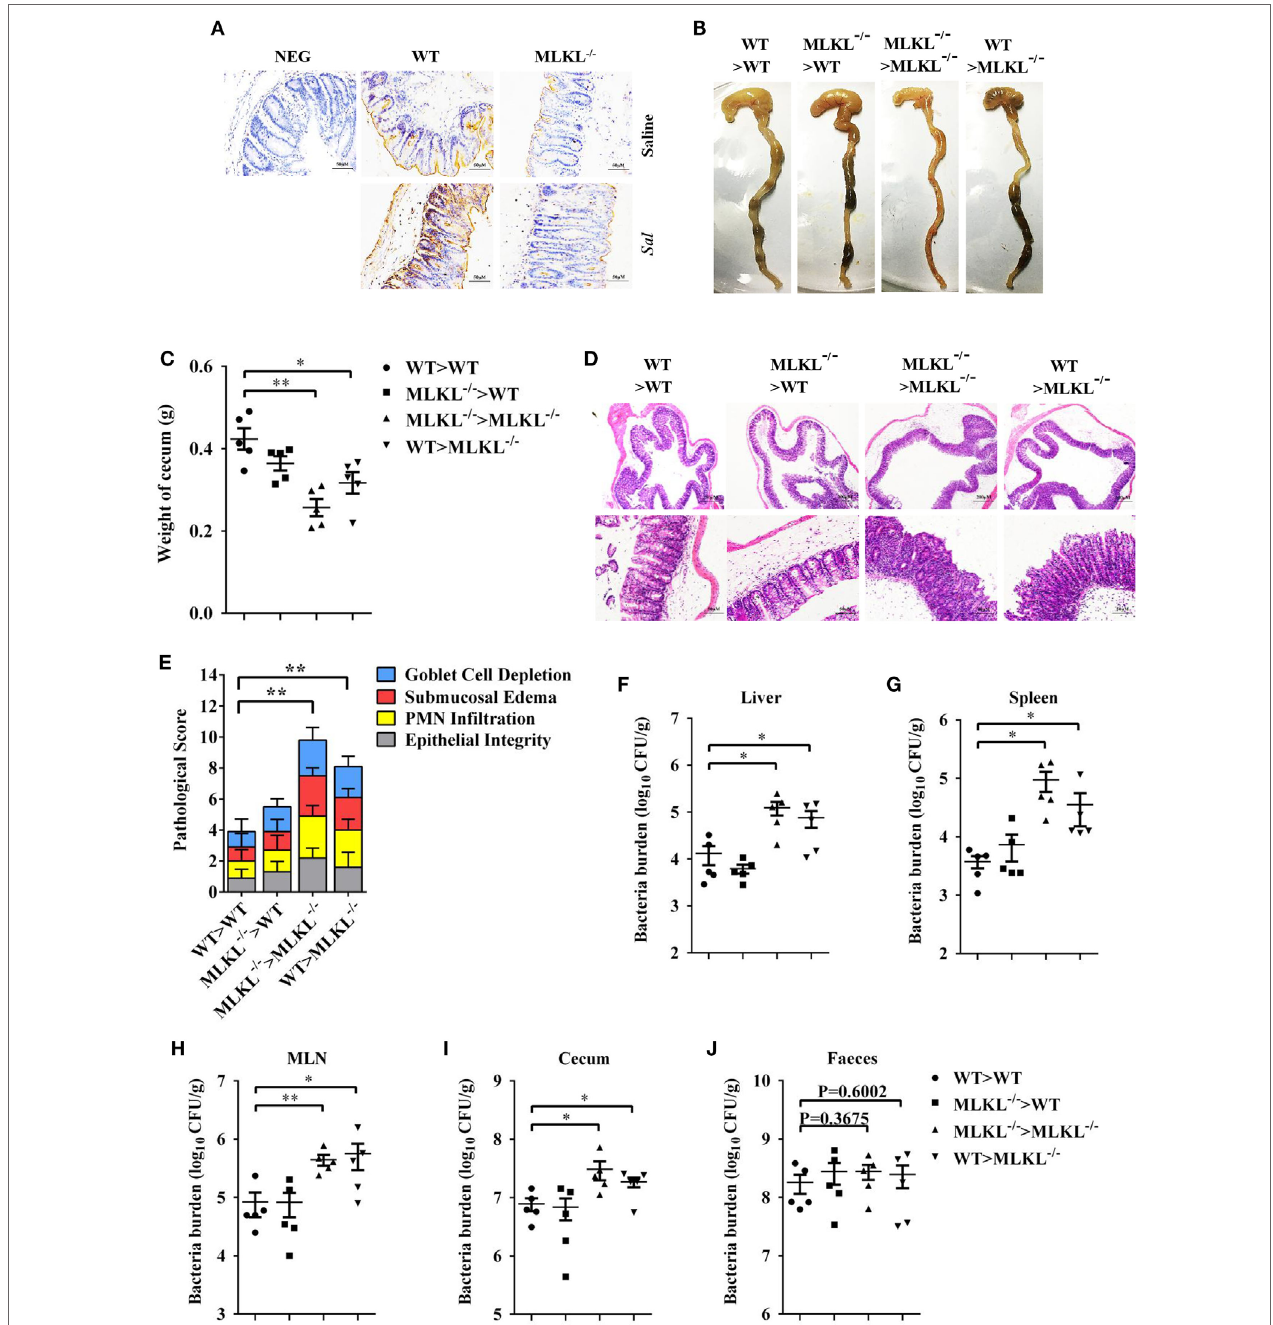
FigUre 6 | MLKL expression in non-hematopoietic cells contributes to protection during Salmonella infection. Streptomycin-pretreated WT and MLKL − / − mice were orally infected with Salmonella (5 × 10 7 CFU, n = 10 each group) for 48 h. (a) Representative cecum sections. Phosphorylated MLKL (p-MLKL IHC) stained brown. (B–J) MLKL − / − and WT bone marrow chimeric mice were generated as described in Section “Materials and Methods.” Streptomycin-pretreated mice were infected orally with Salmonella (5 × 10 7 CFU, n = 5 each group). (B,c) Gross appearance and weight of cecum. (D,e) Representative H&E staining of cecum tissue and pathological score, and bacteria numbers in livers (F) , spleens (g) , MLN (h) , cecum (i) , and feces (J) were determined. All data are shown as mean ± SEM. Student’s t -test was performed. Statistical significance is indicated by * p < 0.05, ** p <